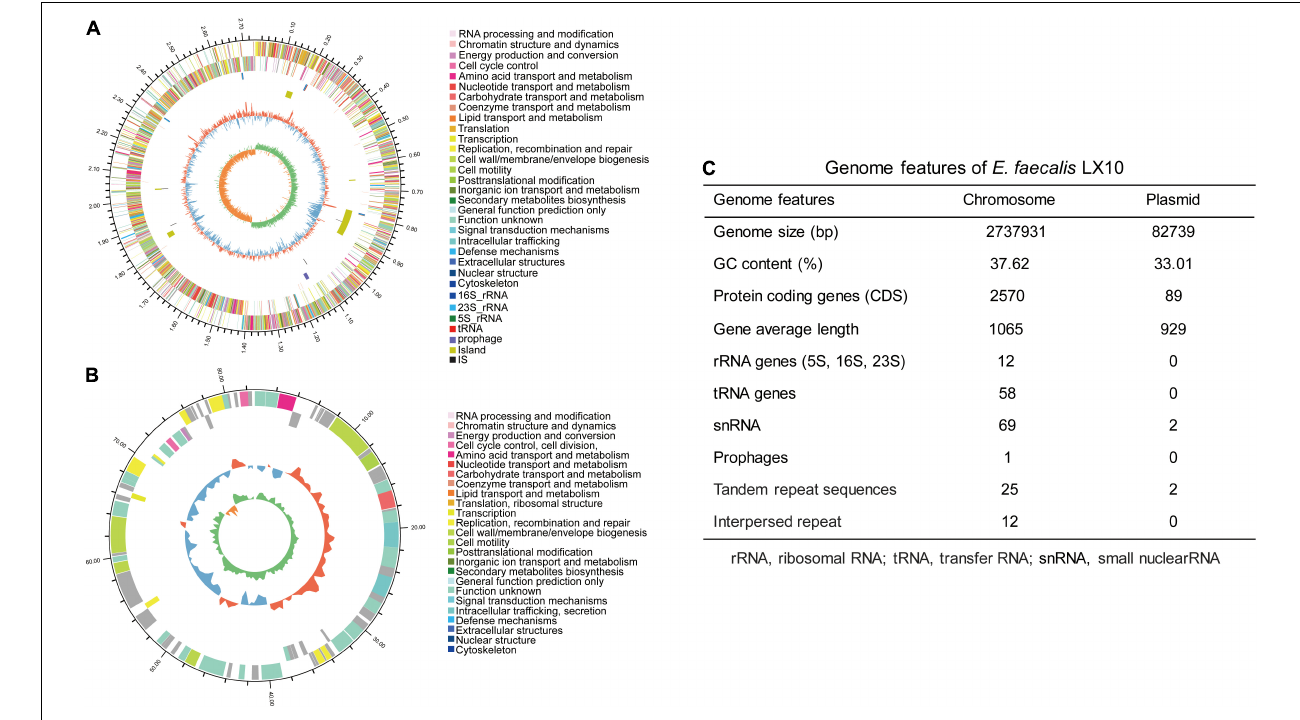
FIGURE 4 | E. faecalis strain LX10 genome resources and characteristics. Circular representation of the chromosome (A) and plasmid (B) of E. faecalis strain LX10. The outer circle shows the size of the complete genome; second and third circles: sequences encoding the amino acids of proteins on the + and – strands, with different colors representing different COG functional classifications; fourth circle: rRNA and tRNA; fifth circle: GC content, where the outward red portion indicates that the GC content in this region is higher than the average GC content of the whole genome, and the inward blue portion indicates that the GC content in this region is lower than the whole-genome average, where the higher the peak value is, the greater the difference from the average GC content; and sixth circle: GC skew value (G–C/G + C). When the value is positive, the CDS is more likely to be transcribed from the positive chain; otherwise, the CDS is more likely to be transcribed from the negative chain. (C) Genome features of E. faecalis